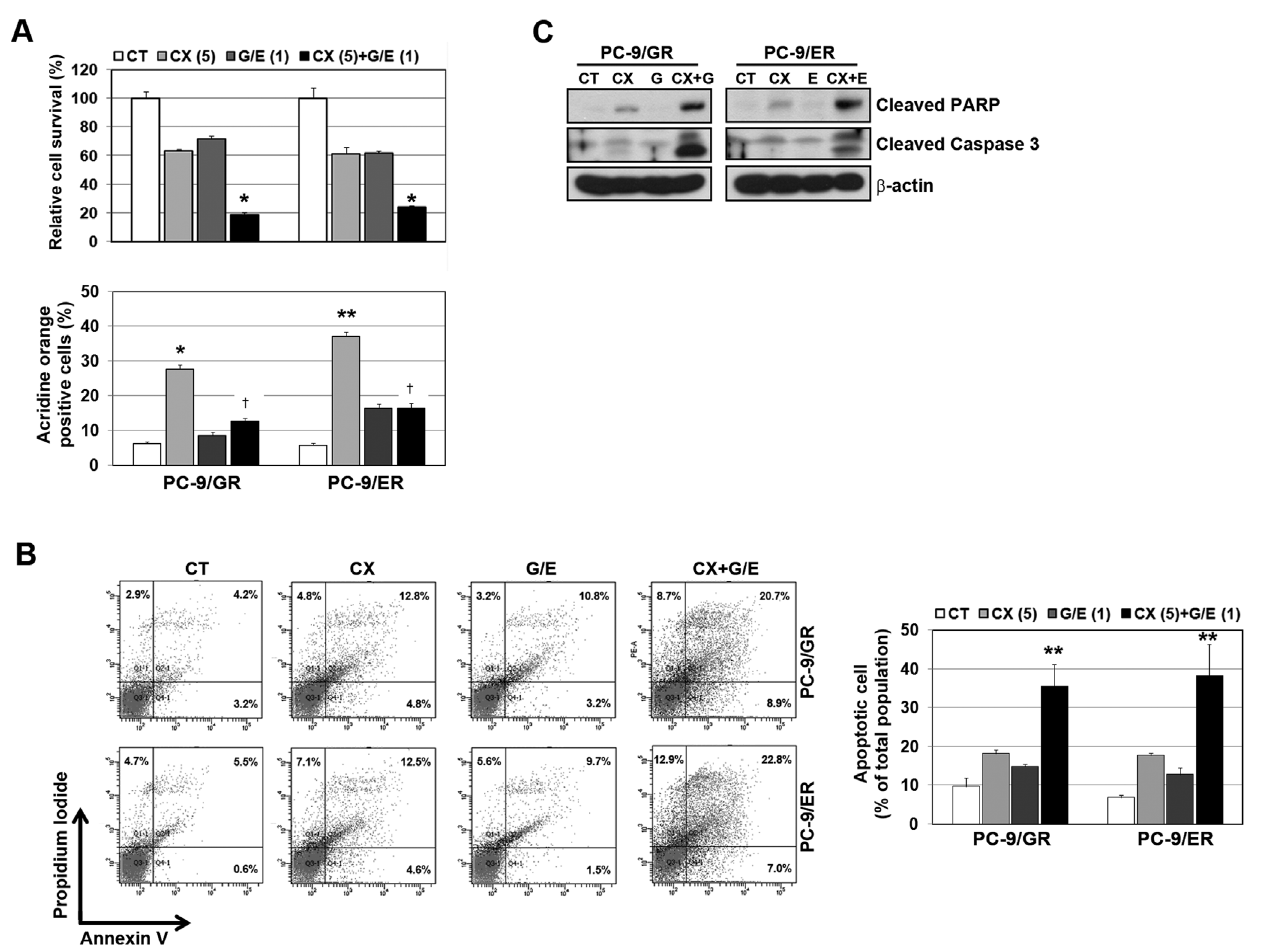
Figure 3. CX-4945 enhanced the efficacy of EGFR-TKIs to overcome drug resistance caused by T790M. Cells were treated with CX-4945 (5 m M), gefitinib (1 m M), and erlotinib (1 m M) or a combination of CX-4945 and gefitinib or CX-4945 and erlotinib for 48 h. A, Cell numbers were determined using a cell counter (upper panel). Quantitative detection of acidic vesicular organelles by acridine orange staining of cells was determined by FACS analysis (lower panel). { p , 0.01 compared with CX-4945 alone. B, Apoptosis was assessed by Annexin V-FITC/Propidium iodide staining and flow cytometry. Diagrams of Annexin V-FITC/Propidium iodide flow cytometry in a representative experiment are presented at the left panel. The results are representative of at least 3 independent experiments, and the error bars signify standard deviations ( ¡ SDs). C, Cleavage of PARP-1 and caspase-3 was shown by Western blot analysis. *p , 0.01 and **p , 0.001 compared with the